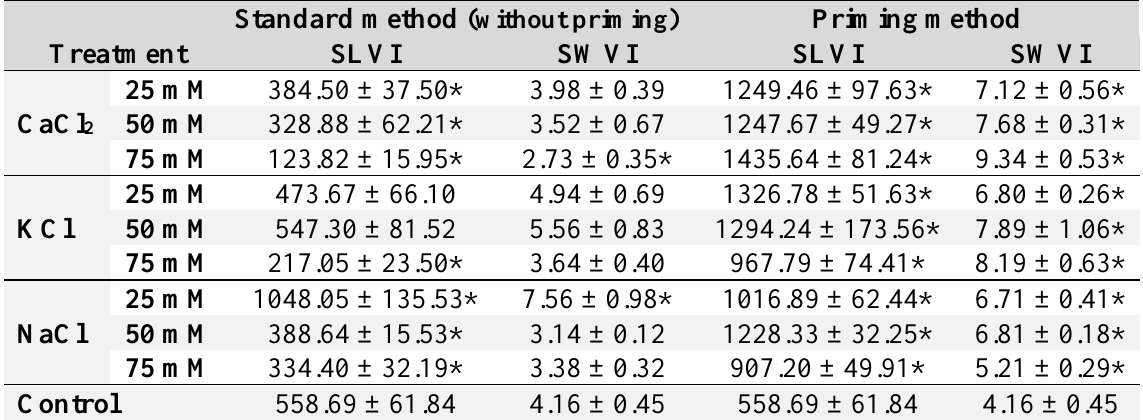
Table 5. Effect of different methods of germination on seedling length (SLVI) and seedling weight (SWVI) vigor index of Raphanus sativus